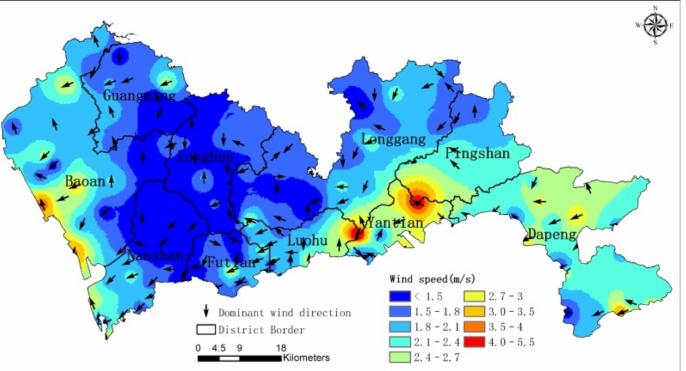
Figure 3. Spatial distribution of the annual average wind speed and dominant wind direction from 2016 to 2018.